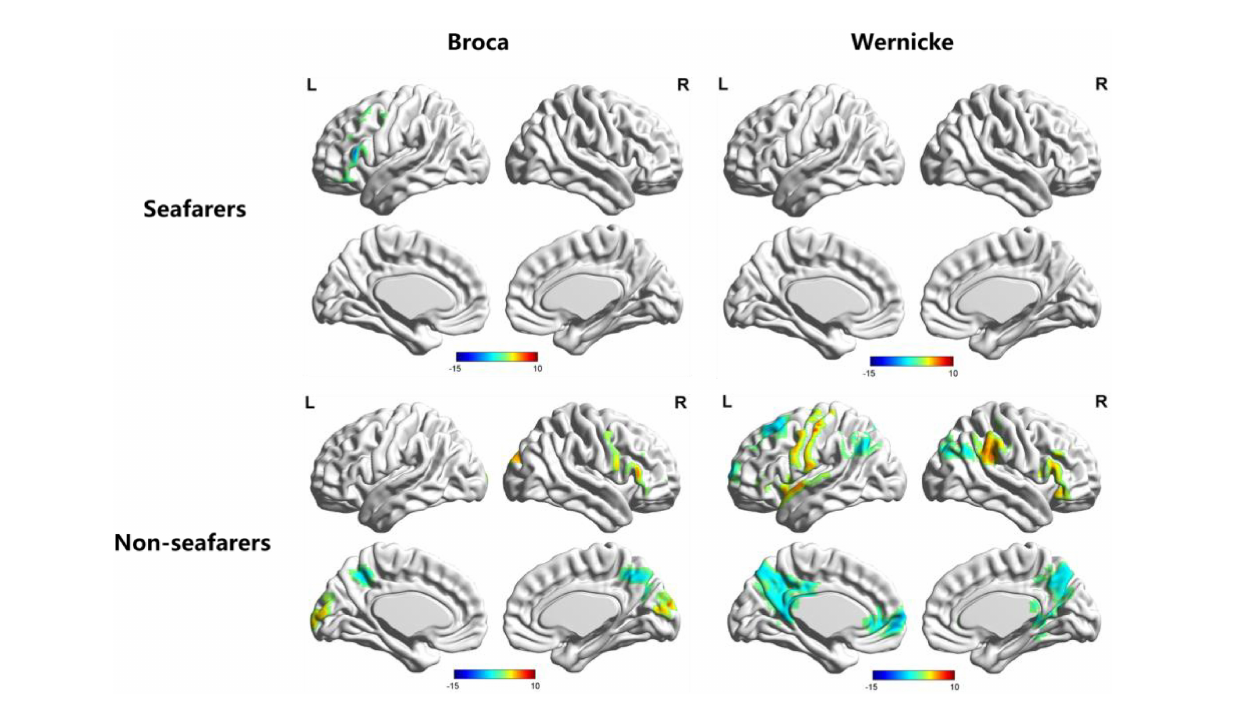
FIGURE4 AI maps with regard to functional lateralization of language network in the seafarer and non-seafarer groups, respectively ( p 0.005, cluster size > 200 voxels, corresponding to corrected p FWE 0.05). R: right hemisphere; L: left hemisphere.